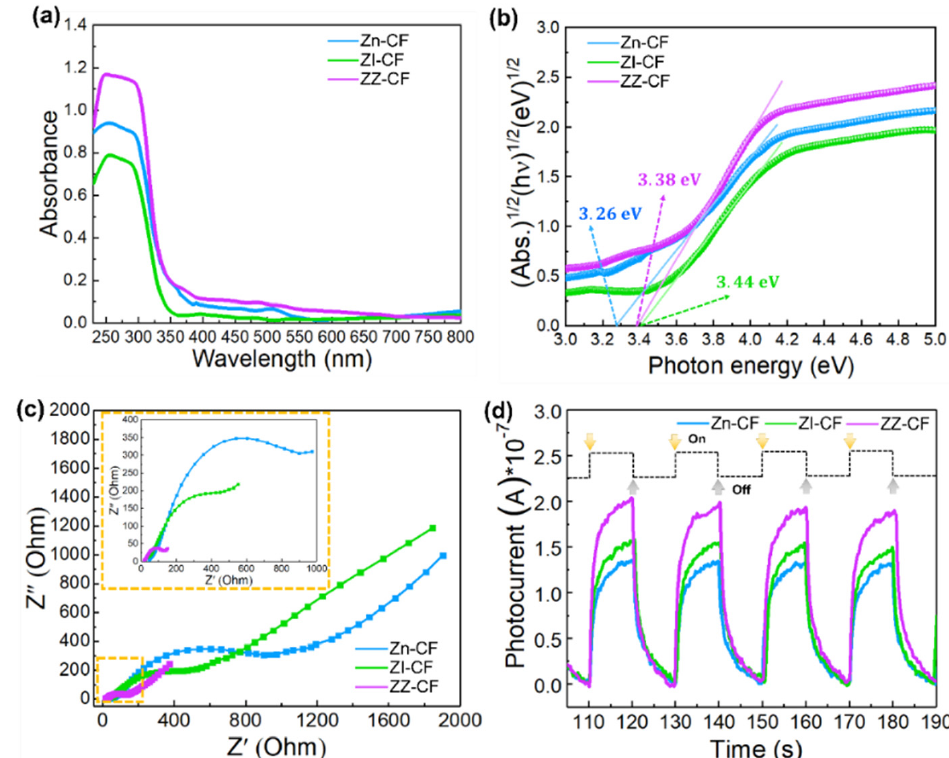
Figure 5. ( a ) DRS curves of Zn–CF, ZI–CF, and ZZ–CF, respectively; ( b ) Energy gap analysis of Zn–CF, ZI–CF, and ZZ–CF, respectively; ( c ) EIS and Nyquist plots with the equivalent circuit of Zn–CF, ZI–CF, and ZZ–CF, respectively; ( d ) Transient photocurrent of Zn–CF, ZI–CF, and ZZ–CF, respec- tively.